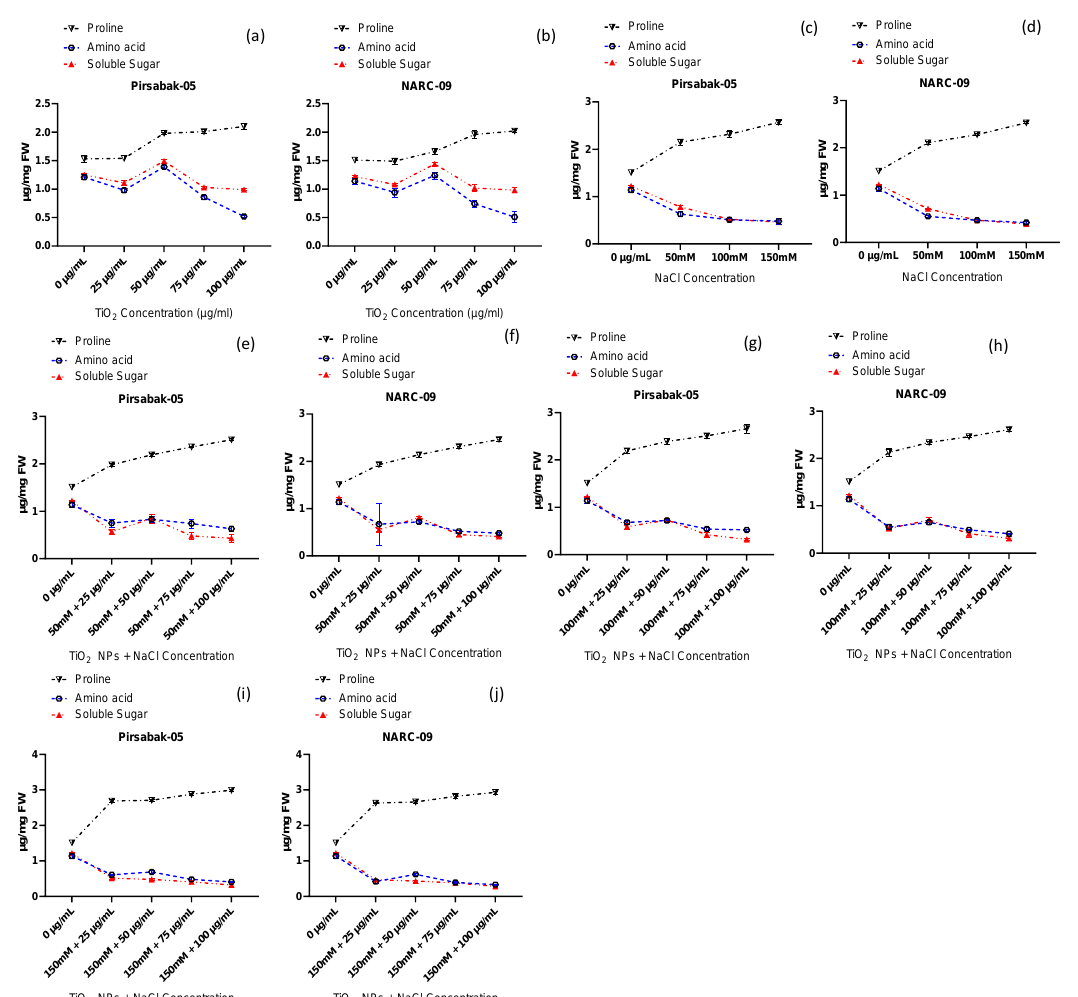
Figure 7. Effects of biogenic TiO 2 NPs on different biochemical traits (proline content, free amino acid content and soluble sugar content) of selected wheat varieties under salinity stress conditions; ( a , b ) Effect of different concentrations of biogenic TiO 2 NPs on wheat varieties Pirsabak-05 and NARC-09, ( c , d ) Effect of different concentrations of NaCl on wheat varieties Pirsabak-05 and NARC- 09, ( e , f ) Effect of different concentrations of TiO 2 NPs under 50 mM of NaCl on wheat varieties Pirsabak-05 and NARC-09, ( g , h ) Effect of different concentrations of TiO 2 NPs under 100 mM of NaCl on wheat varieties Pirsabak-05 and NARC-09, ( i , j ) Effect of different concentrations of TiO 2 NPs under 150 mM of NaCl on wheat varieties Pirsabak-05 and NARC-09. The data are represented in the form of means, while p was kept at p ≤